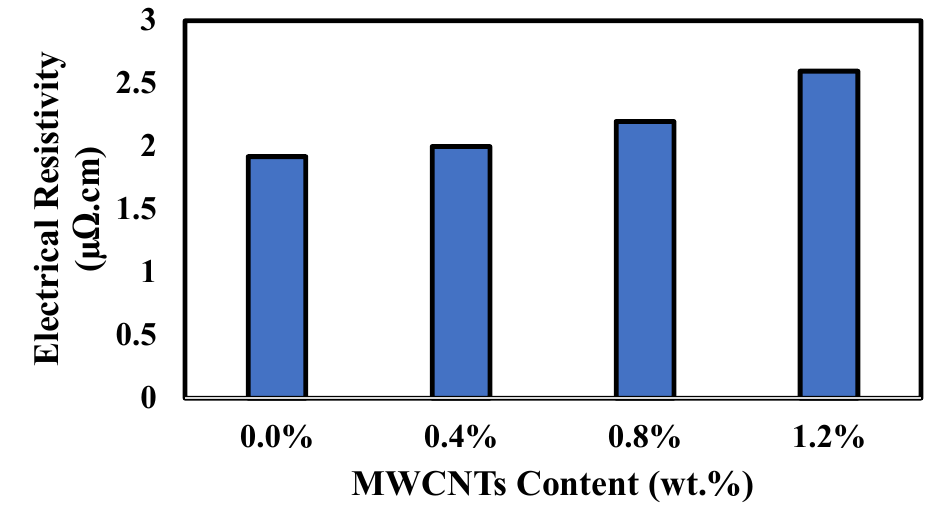
Figure 6. Electrical resistivity of MWCNT content on Cu nanocomposites. Table 3. The electrical resistivity and thermal conductivity of Cu reinforced with MWCNTs.